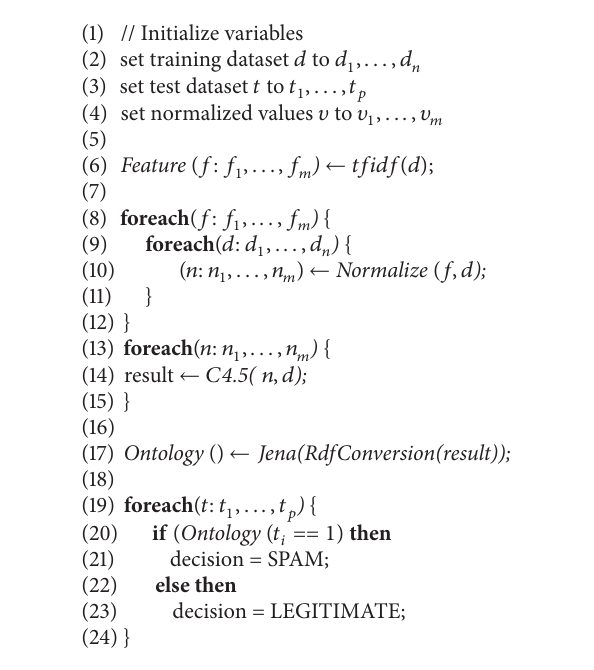
Algorithm 1: Global ontology filter